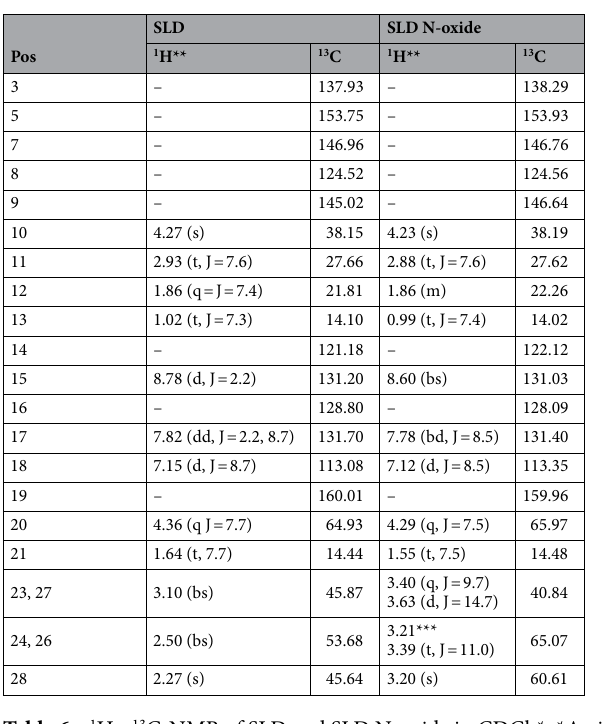
Table 6. 1 H-, 13 C-NMR of SLD and SLD N-oxide in CDCl 3 *. *Assignments based on COSY, HSQC, HMBC,